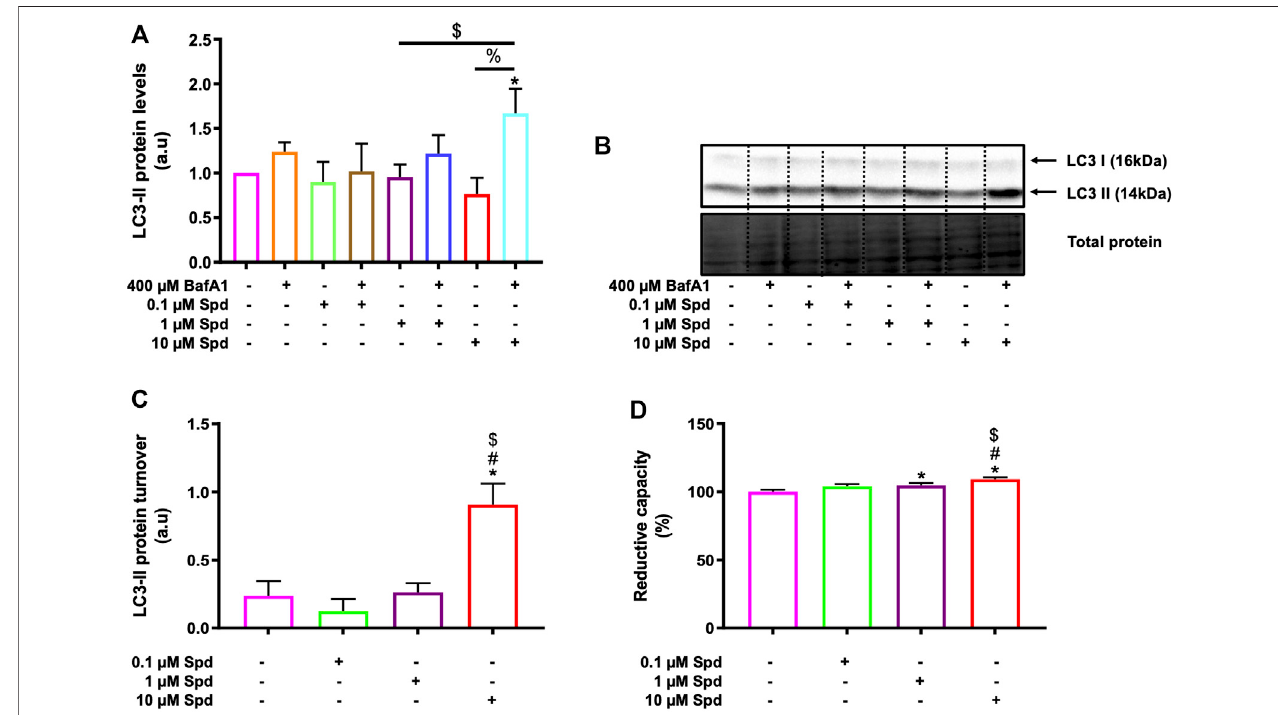
FIGURE 1 | Spermidine induces autophagic fl ux and improves cellular viability in a concentration-dependent manner. (A) densitometric quanti fi cation and (B) representative western blot for LC3-II protein levels upon autophagy induction using three different concentrations(0.1, 1 and 10 μ M) ofspermidine in thepresence and absence saturating concentrationsof ba fi lomycin. Dataare presented as mean ± SEM, n = 3. * = p < 0.05 vs. control, $ = p < 0.05 vs. 0.1 μ M Spd + BafA1 and % = p < 0.05 vs. 10 μ M Spd, arbitrary units (a.u). (C) LC3-II turnover revealing a concentration-dependent fl ux by spermidine. * = p < 0.05 vs. control, # = p < 0.05